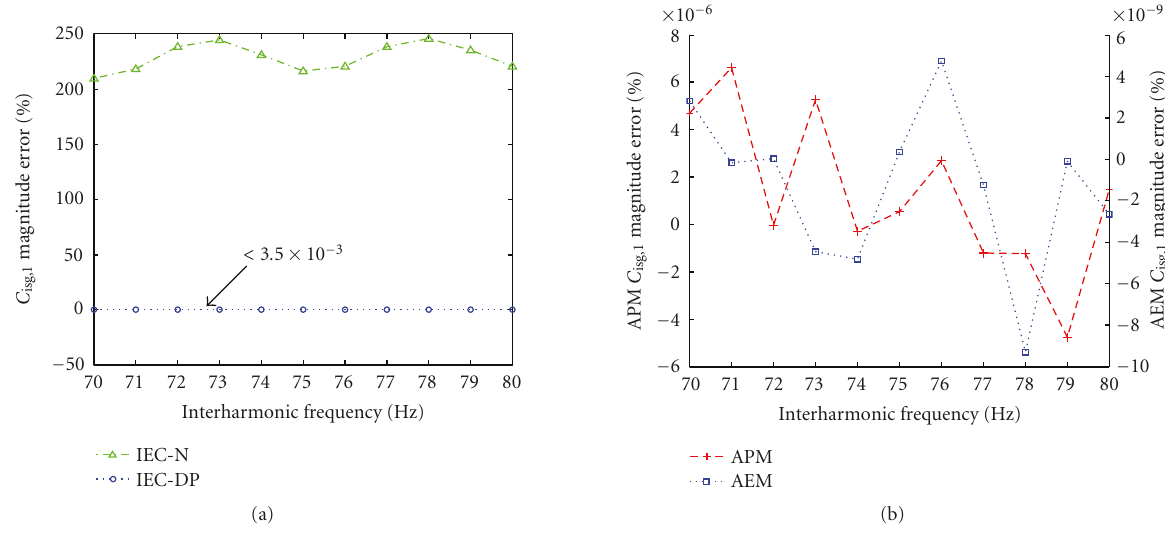
Figure 7: Case study 2: interharmonic subgroup C isg,1 magnitude error (in %) versus interharmonic frequency: (a) IEC-N (- · - Δ ) and IEC- DP (dotted line ◦ ), (b) APM (dotted line +) and AEM (dotted line (cid:3) ).